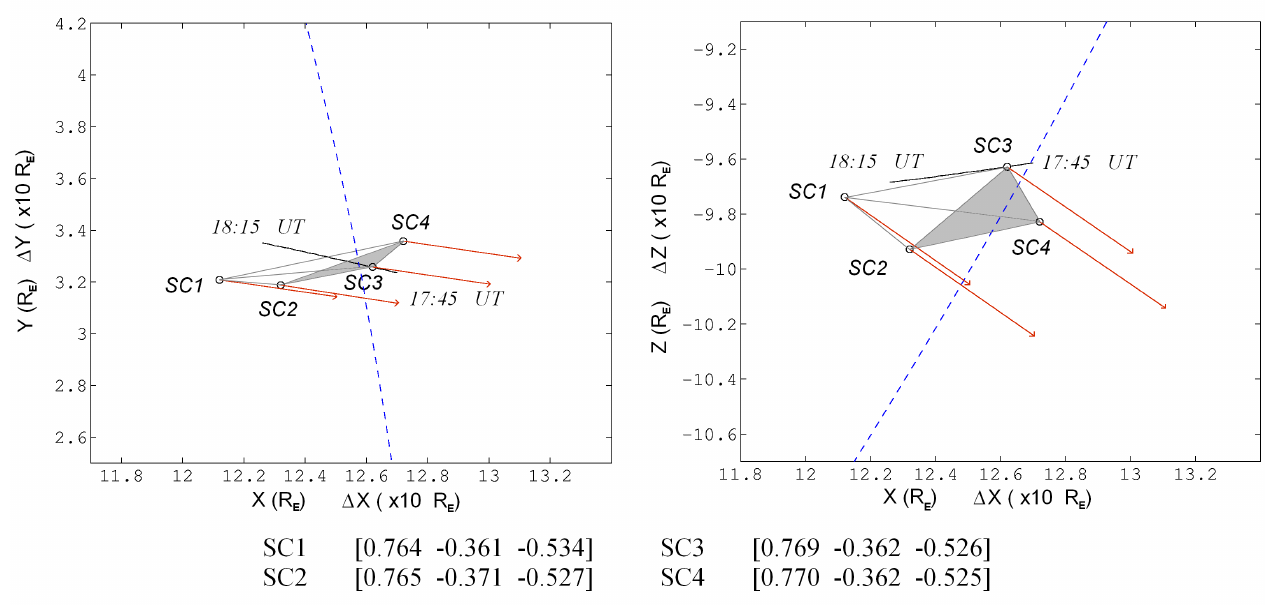
Fig. 3. Cluster spacecraft 3 orbit on 17 February 2004 from 17:45UT to 18:15UT projected in the X-Y (left) and X-Z (right) GSM planes (black line). The Cluster tetrahedron at 17:50UT is also plotted. The separation distance between spacecraft has been multiplied by a factor of 10. The red arrows represent the components of the magnetopause normal predicted by the minimum variance analysis applied on magnetic field for each spacecraft. The blue dotted curve represents the magnetopause location as predicted by the Shue et al. (1997) model.